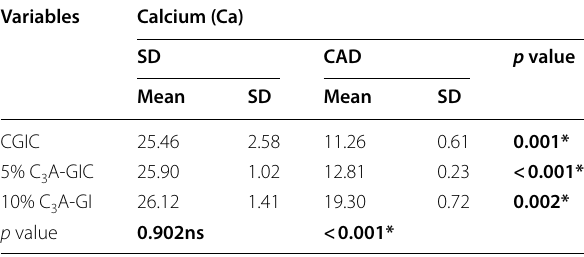
Table 2 The mean, standard deviation (SD) values of calcium of different groups